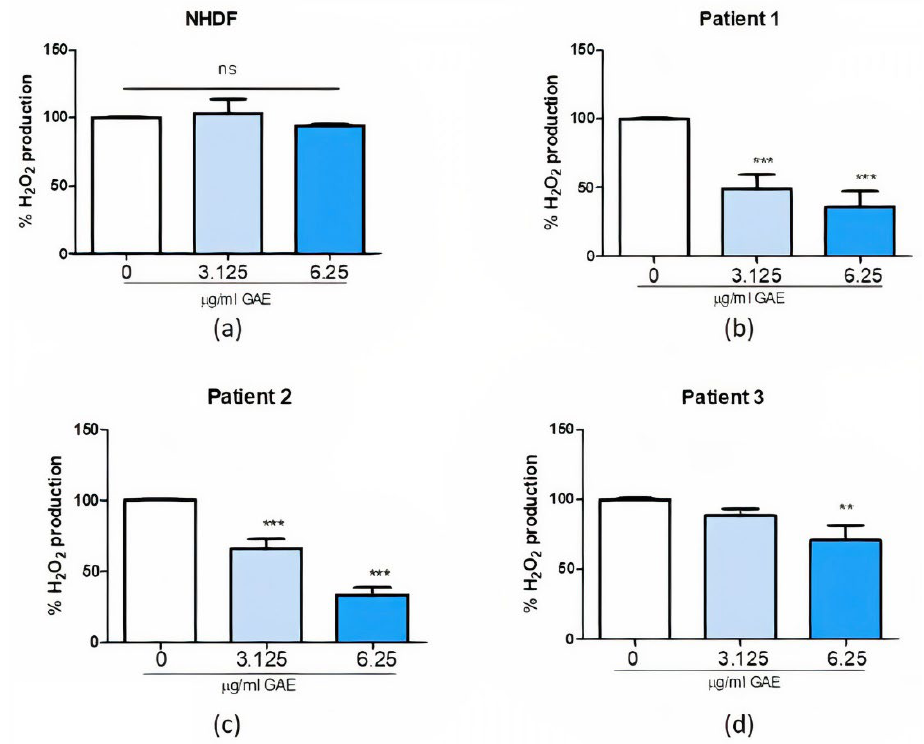
Figure 4. ROS production in NHDF ( a ) and patients ( b – d ) after phenolic sumac extract treatment.